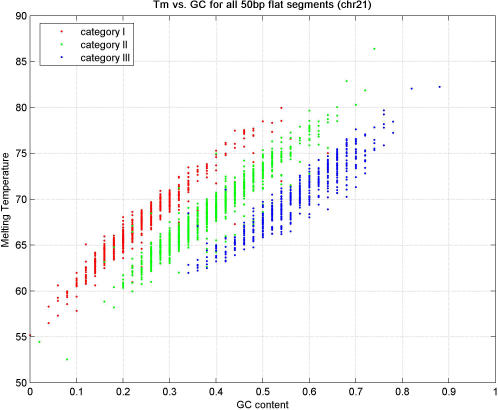
Scatter Plot of Melting Temperature versus GC Content of Flat Melting SegmentsUsing Chromosome 21, the relationship between local GC content and melting temperature was examined for all flat segments of 50 bps. Figure 4 shows the scatter plot of melting temperature versus GC content. Each data point in this figure represents a 50-bp flat segment. The red dots represent those segments that have higher melting temperatures (Tm) in its neighboring regions at both sides (denoted as category I). The blue dots represent those that have lower Tm in its neighbors (denoted as category III). And, the green dots represent those that have lower Tm in one side neighbor and higher Tm in another (denoted as category II).